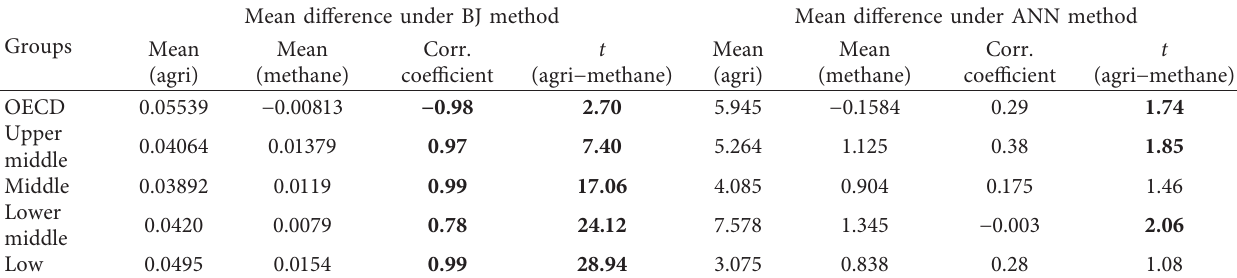
Table 8: Mean difference test